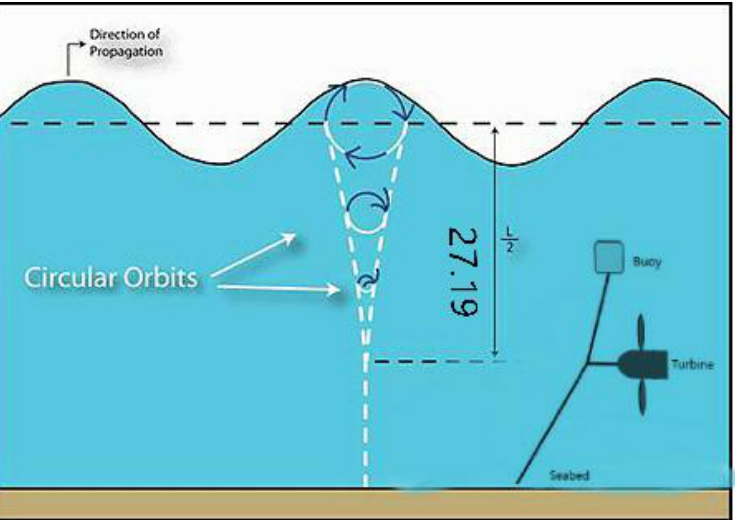
Figure 12. Water particle paths under waves in deep water and the turbine